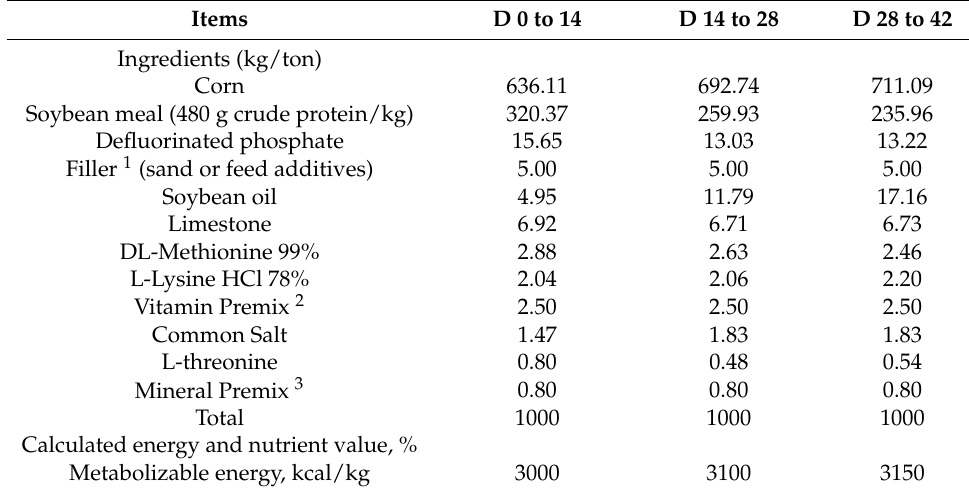
Table 1. Ingredients and nutrient compositions of basal diets (As-fed basis) 1